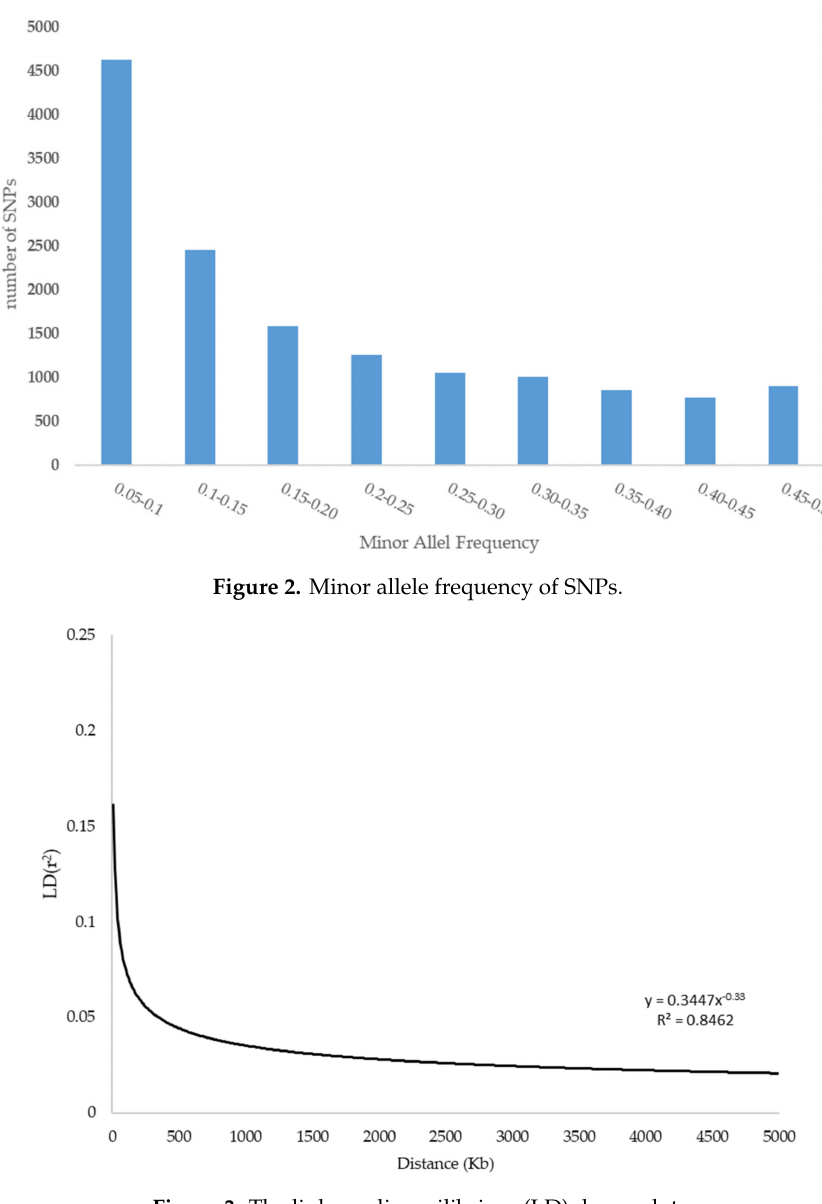
Figure 3. The linkage disequilibrium (LD) decay plot. Table 2. Pairwise linkage disequilibrium ( r 2 ) for SNPs at various